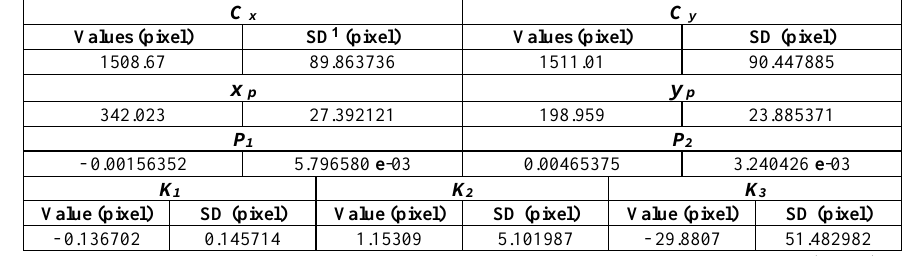
Table 4. Interior orientation parameters and thermal infrared camera lens distortions (pixels).